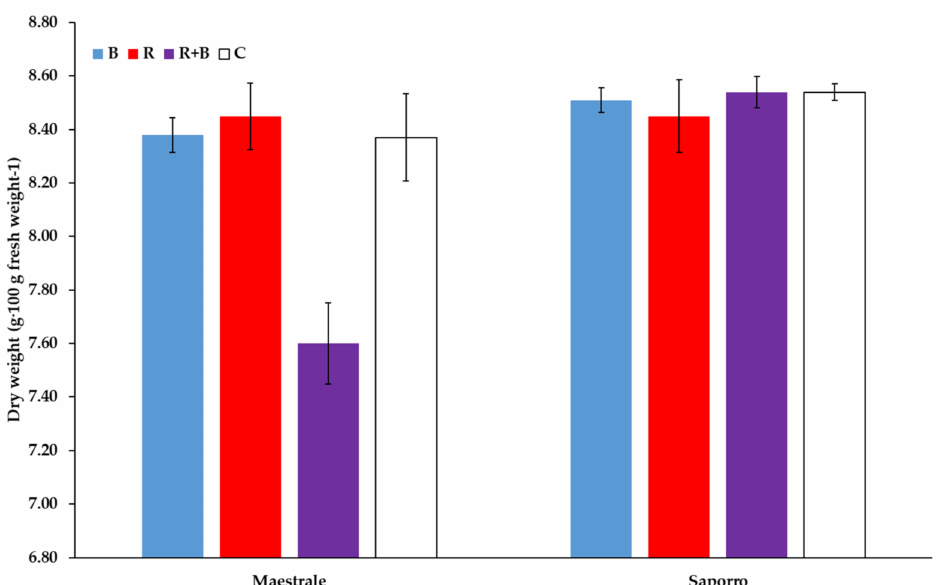
Figure 2. Dry matter content of green bean pods as influenced by interactions between cultivars and light spectra. Vertical bars represent the standard error of mean